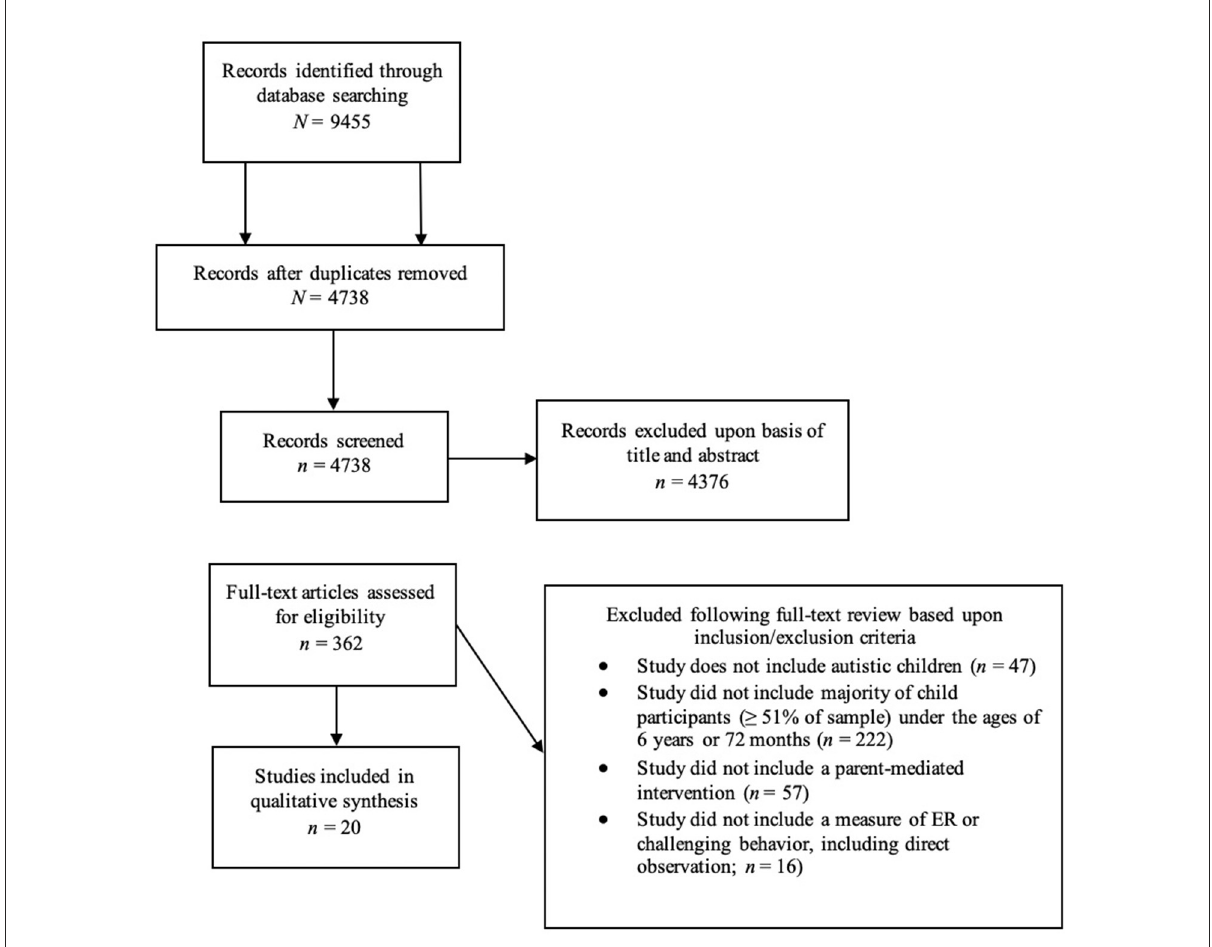
FIGURE1 Flowchart of included and excluded